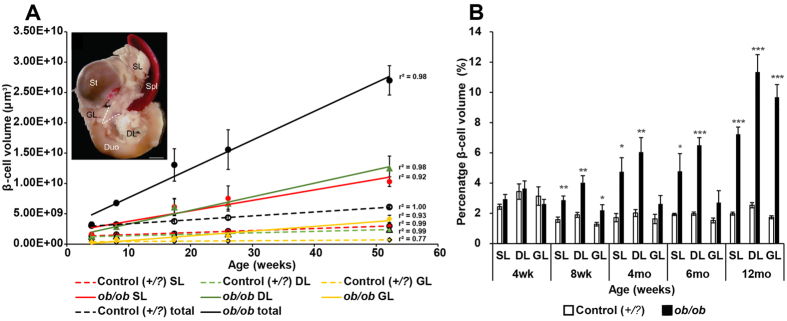
Lobular pancreatic β-cell volumes in ob/ob and lean controls.(A) Graph illustrating the total average (black lines) and lobular splenic (SL, red), duodenal (DL, green) and gastric (GL, yellow) β-cell volumes in lean control (broken lines) and ob/ob pancreata (intact lines). The BCV expansion is close to linear in all groups (r2 scores are indicated). (B) Graph displaying the average percentual β-cell volume in the respective splenic, duodenal and gastric lobes of lean control (white bars) and ob/ob (black bars). Inset shows a photomicrograph of a gut segment including the stomach, duodenum, spleen and pancreas from a C57Bl/6 mouse at 8 weeks, illustrating the delineation of the lobes. Data is shown as means ± SEM (n = 5) where *P < 0.05; **P < 0.01 and ***P < 0.001. Abbreviations: SL, Splenic lobe; DL, Duodenal lobe; GL, Gastric lobe; St, Stomach; Spl, Spleen; Duo, Duodenum. Scale bar in inset is 2 mm.